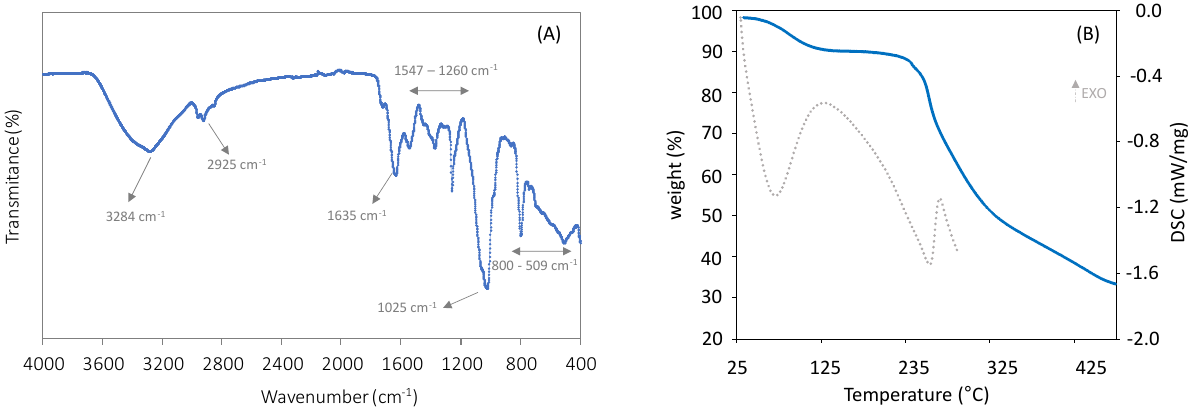
Figure 1. ( A ) FTIR spectrum of the freeze-dried biosurfactant; ( B ) TGA thermogram (full blue line) and DSC curves (dotted grey line) of B. thailandensis freeze-dried biosurfactant.